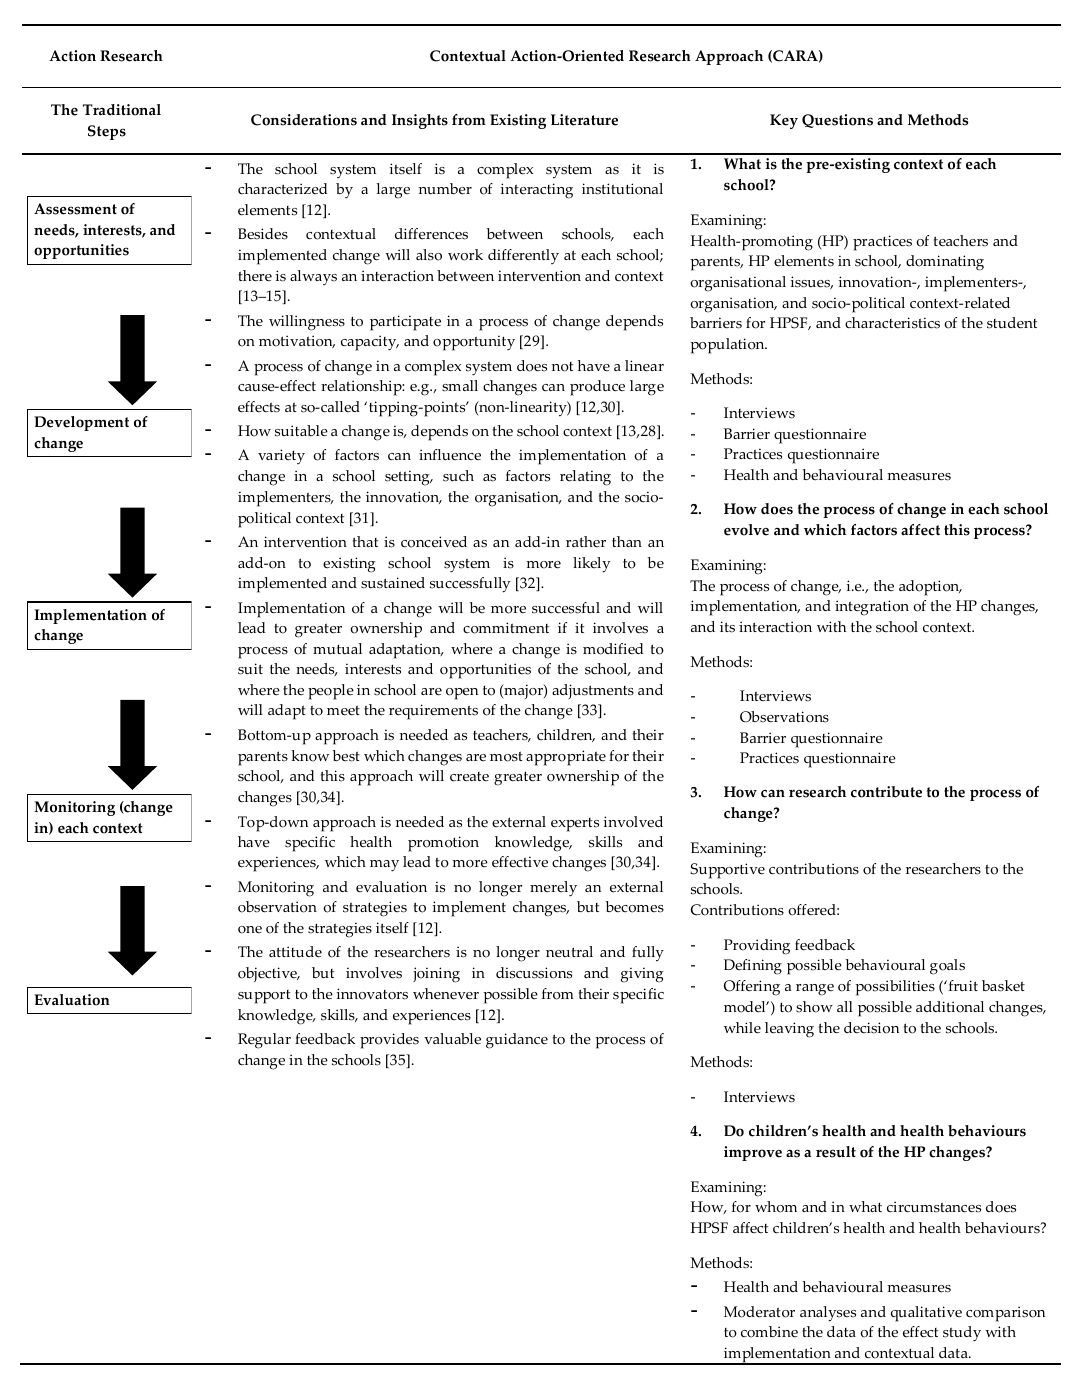
Table 1. Considerations and insights on initiatives in complex systems.